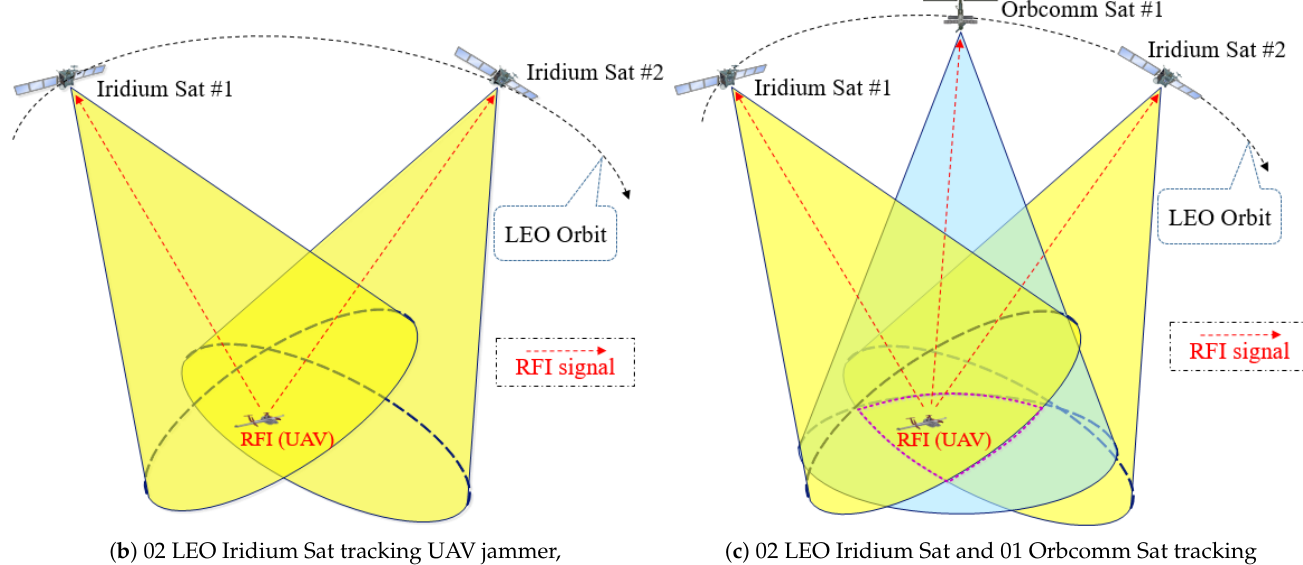
Figure 18. Various scenarios of RFI UAV tracking based on TDOA/FDOA/DDR using Iridium and Orbcomm Sat. in VHF-L band. Authors’ own